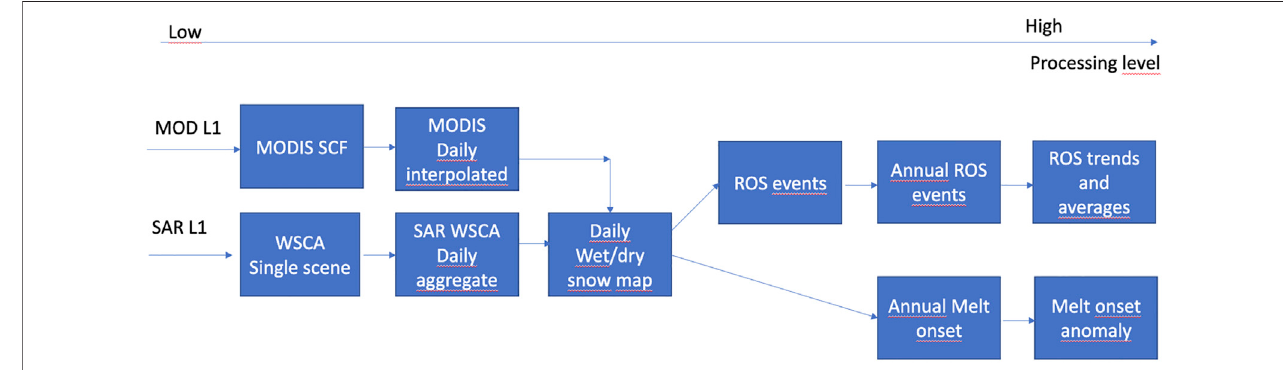
FIGURE6| MapofmeanmeltonsetdatefortheSvalbardarchipelago,fortheperiod2004 – 2020.Thedateshavebeencategorizedintodiscreteintervalssuchthat the lower and upper colors represent melt onset occurring on DOY < 120 or > 180 respectively.